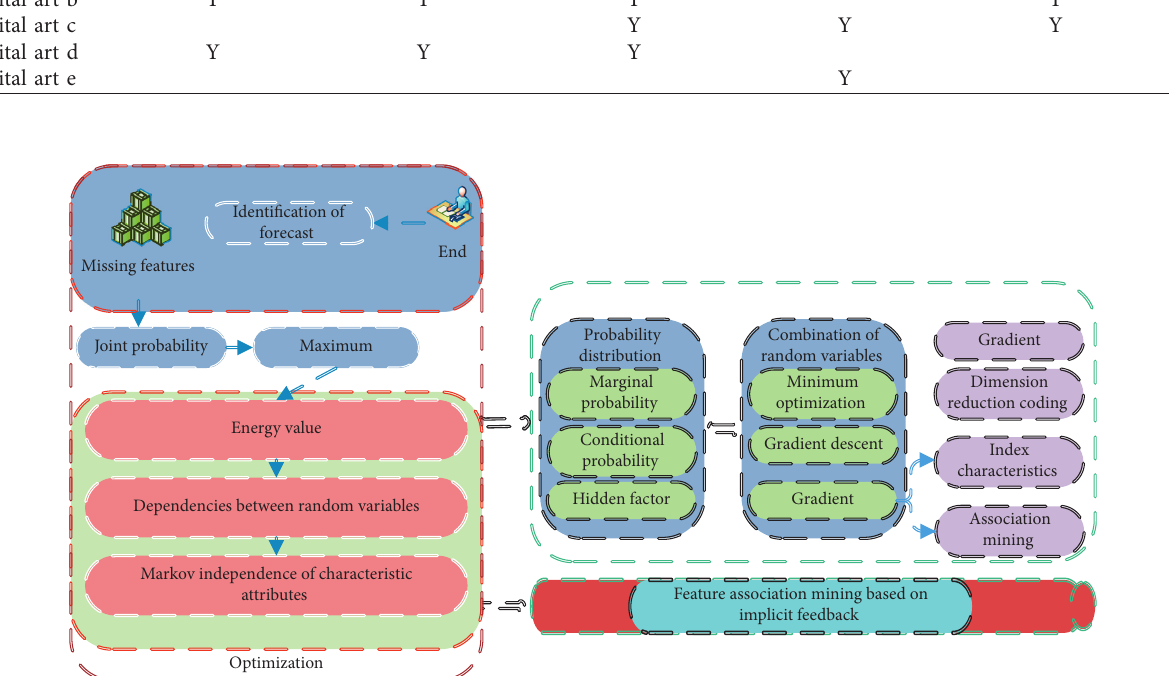
Figure 3: Computational process of the missing feature association mining based on implicit feedback.